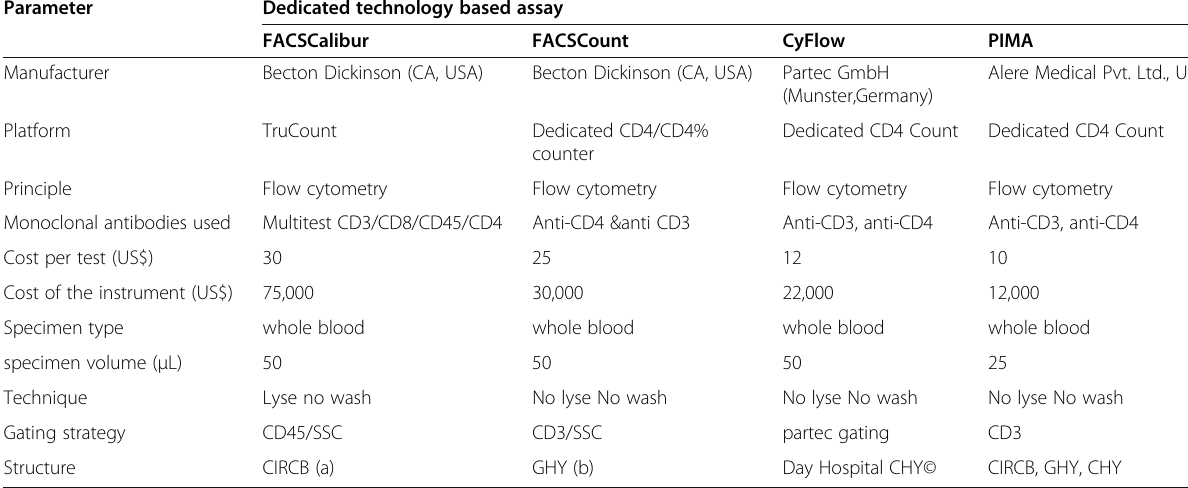
Table 1 Summary of characteristics of various CD4+ T cells enumeration techniques